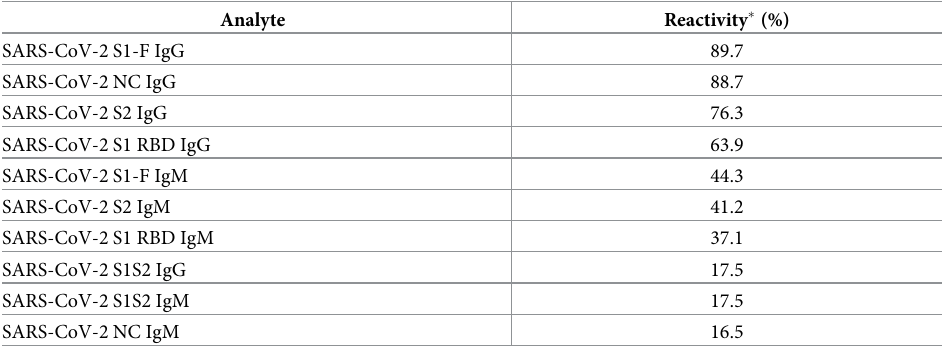
Table 3. Genalyte assay target